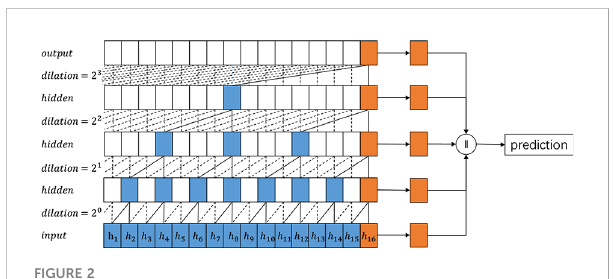
FIGURE 2 An overview of the proposed Pyramid TCN